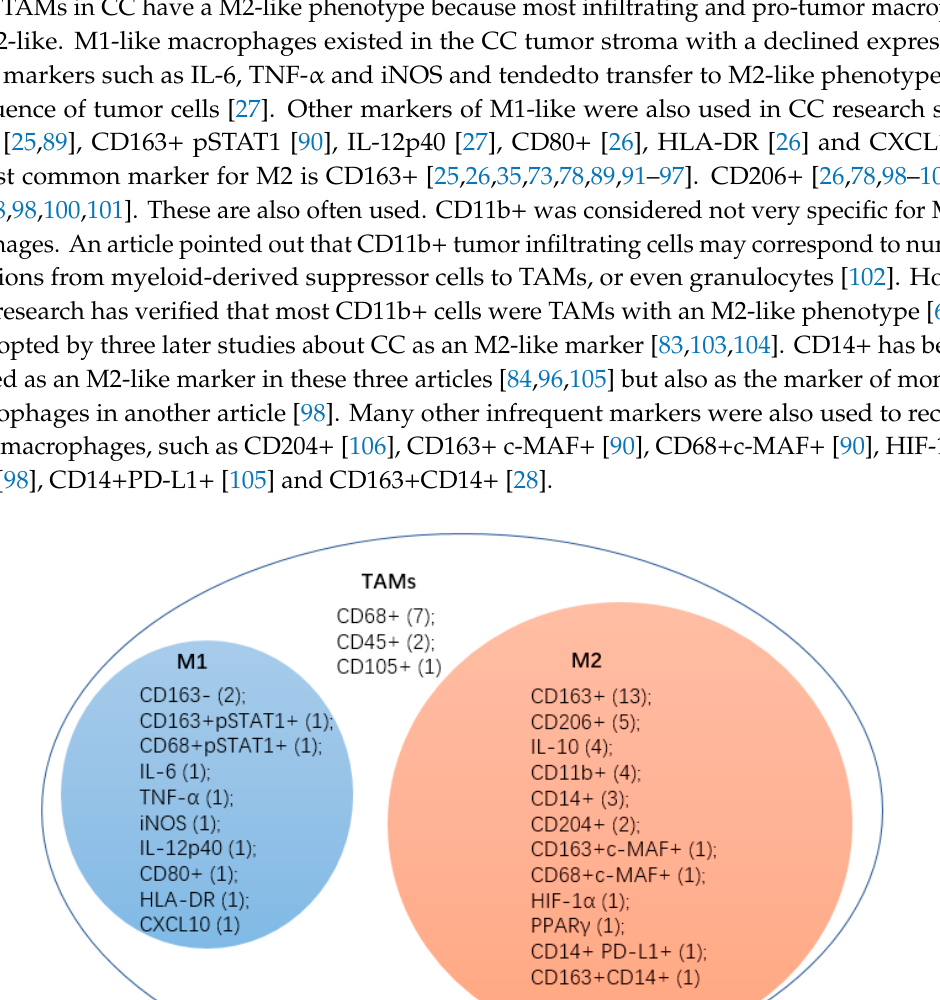
Table 4. Component Involved in the Switch from M2 to M1-like macrophages. Component